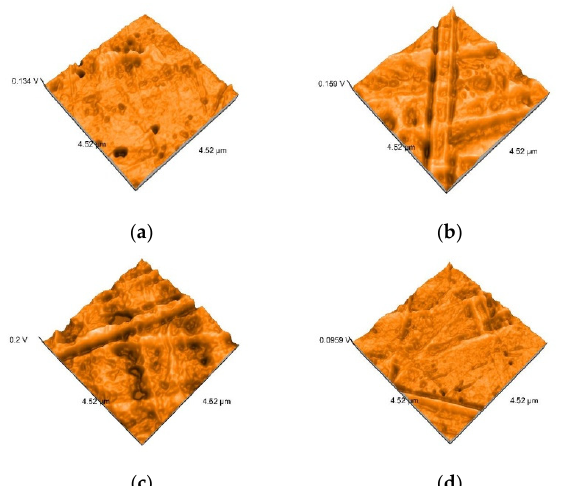
Figure 12. 3D AFM images of the thermoformed S samples after mechanically brushing: ( a ) SCX (Sa = 7.5 nm, Sp = 52 nm, Sv = − 43 nm); ( b ) SKX (Sa = 8.7 nm, Sp = 59 nm, Sv = − 51 nm); ( c ) SWX (Sa = 22 nm, Sp = 85 nm, Sv = − 66 nm); ( d ) STX (Sa = 43 nm, Sp = 89 nm, Sv = − 98 nm).